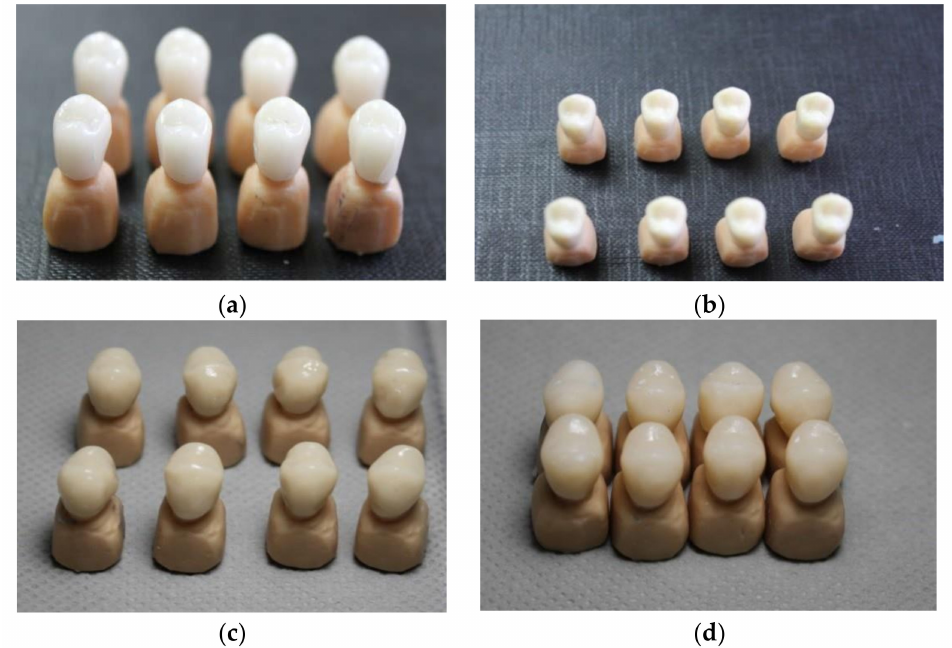
Figure 2. ( a ) Milled feldspathic glass ceramic, ( b ) Milled zirconia reinforced lithium silicate glass ceramic ( c ) Heat-pressed feldpsathic glass-ceramic ( d ) Heat-pressed zirconia reinforced lithium silicate